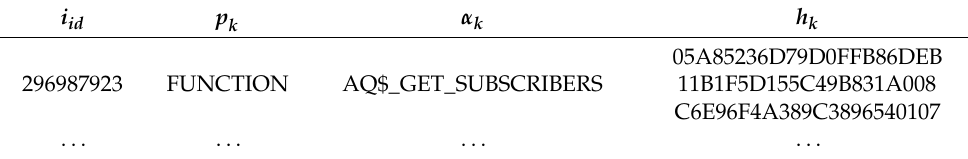
Table 2. An example of a partially filled table of stored